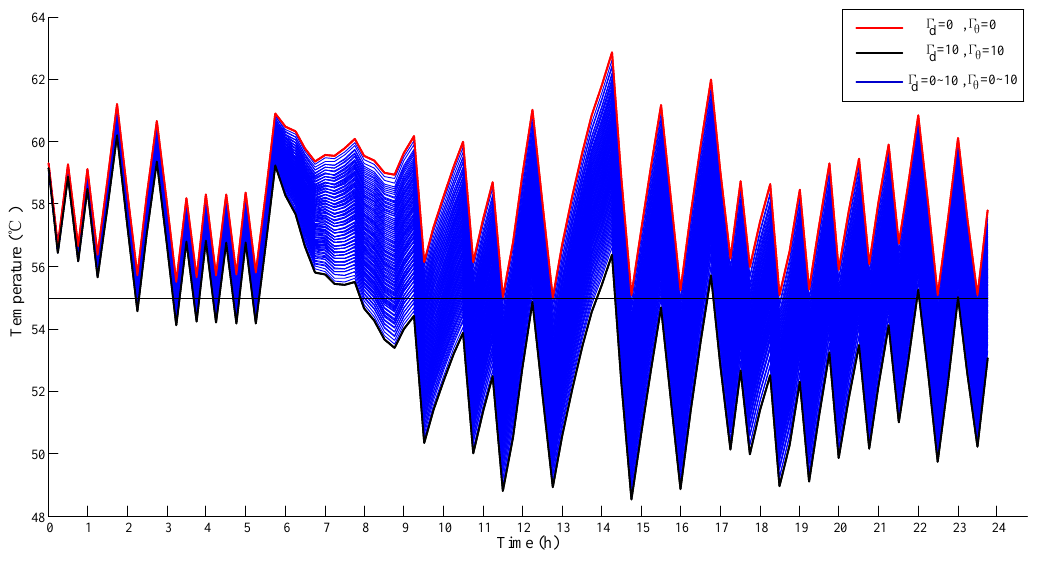
Figure 4. The actual water temperature under 121 scenarios applying the deterministic schedule.